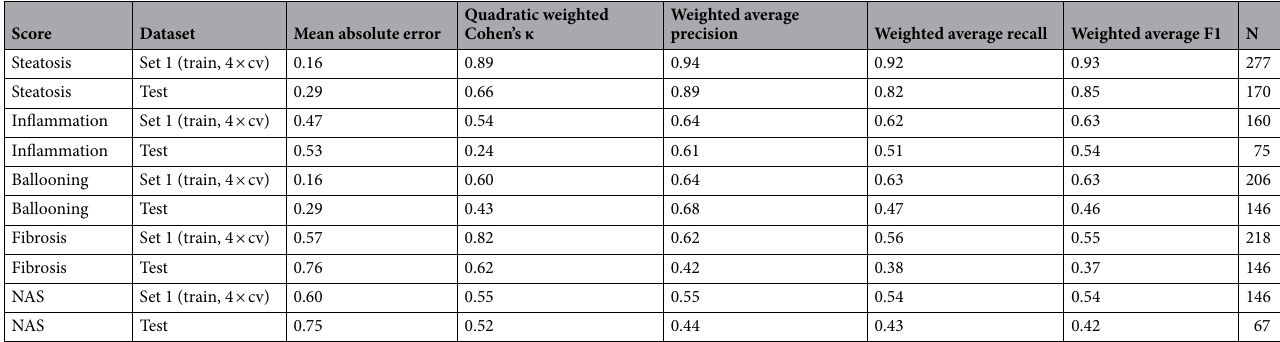
Table 1. Deviation of pathologist scores and AI scores. Performance metrics of scores per slide on set 1 (train set, using fourfold cross validation (4 × cv)) and on set 2 (test set). Note that only the two first performance